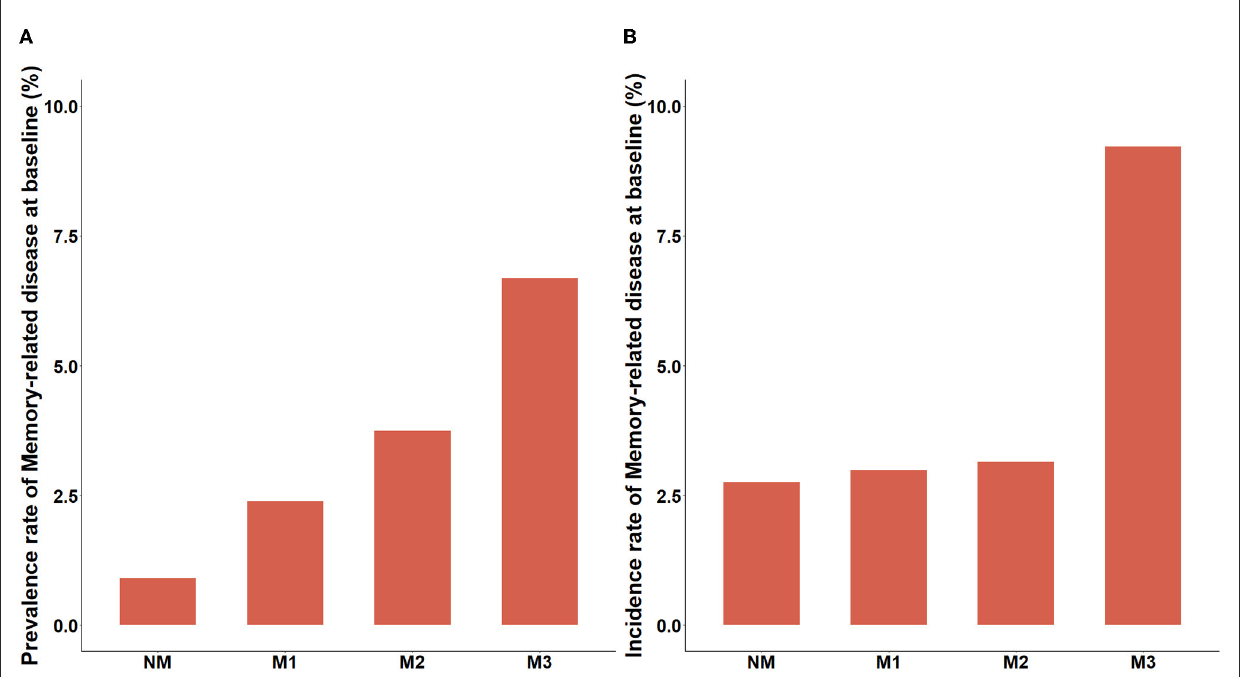
FIGURE2 Epidemiologic feature of memory-related diseases according to the severity of multimorbidity. (A) Prevalence rate of memory-related diseases. (B) Incidence rate of memory-related diseases. NM, participants with no or one NCD; M1, participants with two NCDs; M2, participants with three NCDs; M3, participants with four or more NCDs.